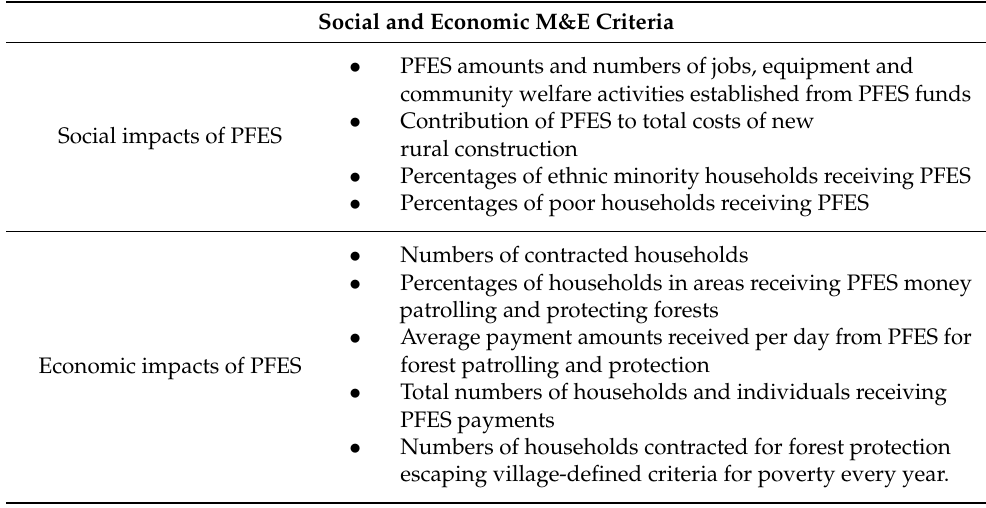
Table 1. Monitoring and evaluation criteria for assessing the socio-economic impacts of